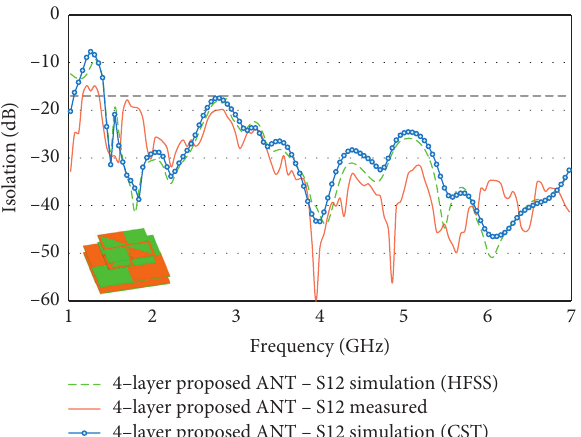
Figure 8: Measured and simulated isolation versus frequency of the proposed